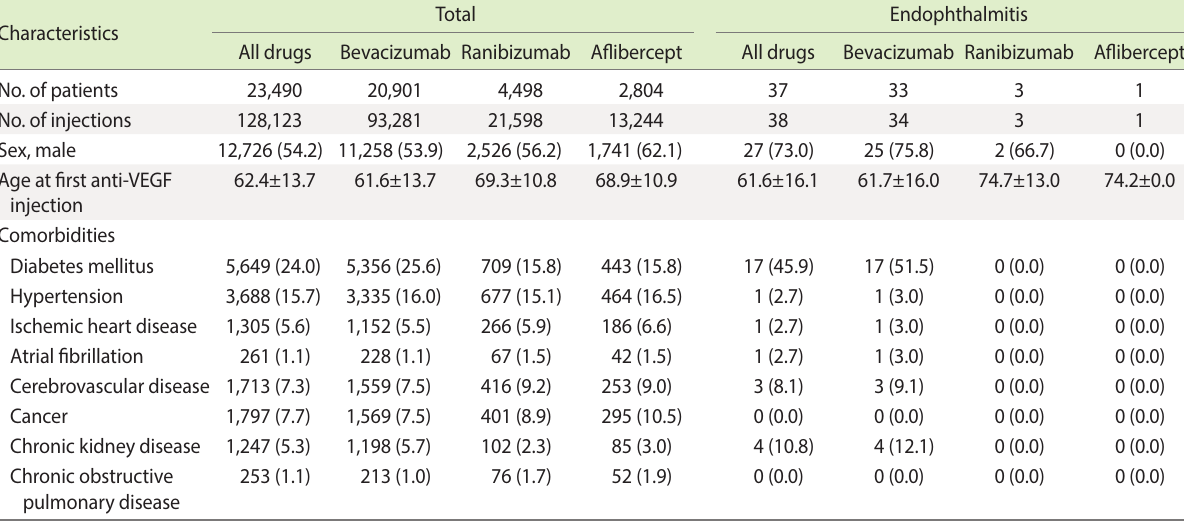
Table 2. Demographic characteristics of patients treated with intravitreal anti-vascular endothelial growth factor (VEGF) and endophthal- mitis cases from 2007 to 2018